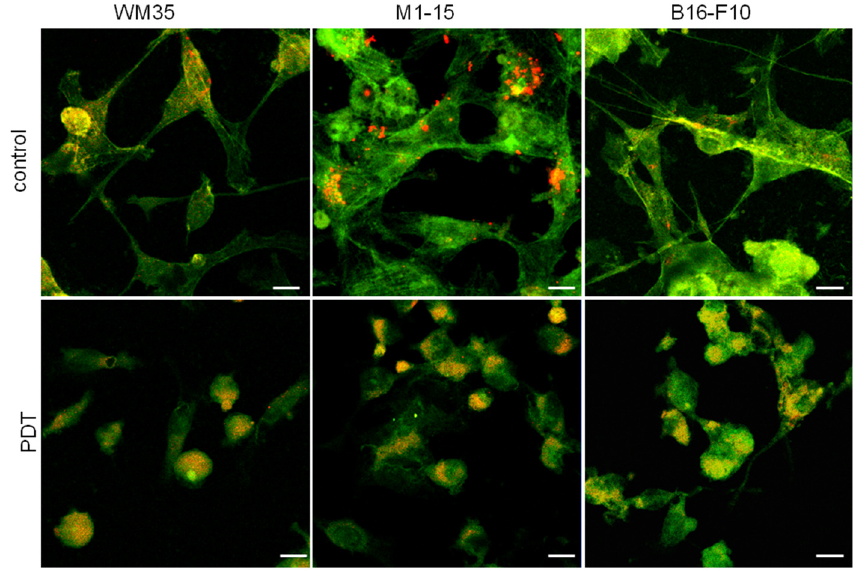
Figure 2. Cytoskeleton morphology. Confocal microscopy images of WM35, M1-15, and B16-F10 cells co-cultured with HUVEC (PKH 26 positive) stained with phalloidin-FITC, control (upper panels), PDT-treated (THPP 15 µg/mL and irradiation 100 mJ/cm 2 —lower panels), original magnification 63×, bar = 20 µm.